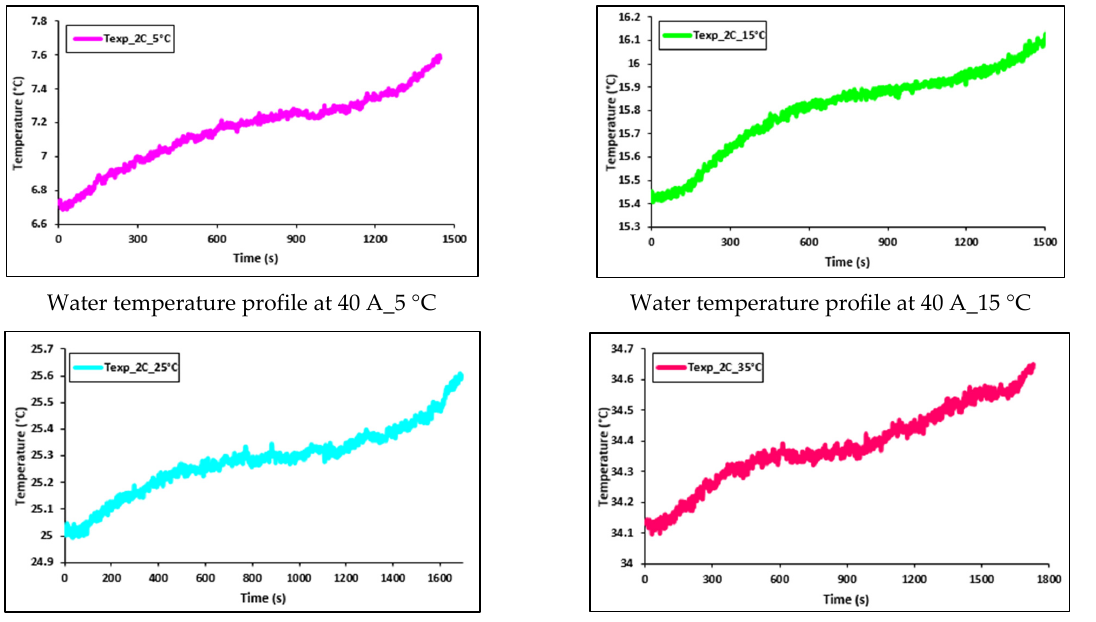
Figure 18. Transient temperature profile of water flow at 40 A with 5 °C, 15 °C, 25 °C, and 35 °C.